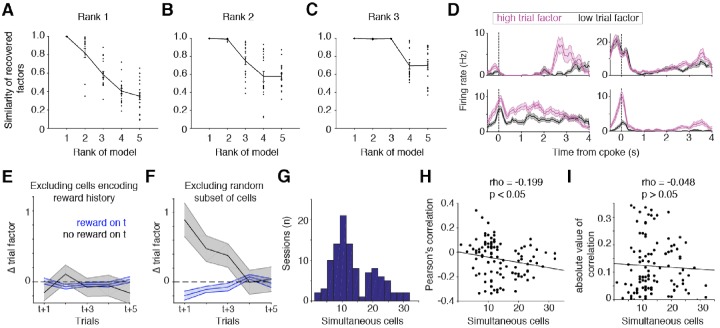
TCA/PARAFAC tensor decomposition applied to neural data.(A–C) Method used to determine model rank. We performed 20 random initializations and compared the similarity of the factors recovered from each iteration to those recovered from the previous one. We show the distribution of similarity indices for example recording sessions that were determined to be rank 1, 2, and 3 (A,B,C, respectively). Black lines are mean ± s.e.m. The majority of the data was either rank 1 or 2 (50/105 sessions were rank 1, 50/105 were rank 2, 5/105 were rank 3), so for simplicity, we fit a rank one model to each session. (D) Four neurons from the recording session in panel 3D; firing rates are plotted when the trial factor was high (>85 th percentile) or low (<15 th percentile). (E) Mean (± s.d.) shuffle-corrected reward (blue) and no-reward (black) triggered averages of trial factors across all sessions (see Materials and methods), excluding cells that had significantly different spike counts following rewarded or unrewarded trials. (F) Mean (± s.d.) shuffle-corrected reward (blue) and no-reward (black) triggered averages of trial factors, excluding random subsets of cells, of the same number that were excluded in panel E. (G) Distribution of simultaneously recorded units across all recording sessions. (H) Relationship between the Pearson’s correlation between trial factors and reward history, and number of units recorded in each session. (I) Relationship between the absolute magnitude of the Pearson’s correlation between trial factors and reward history, and number of units recorded in each session.